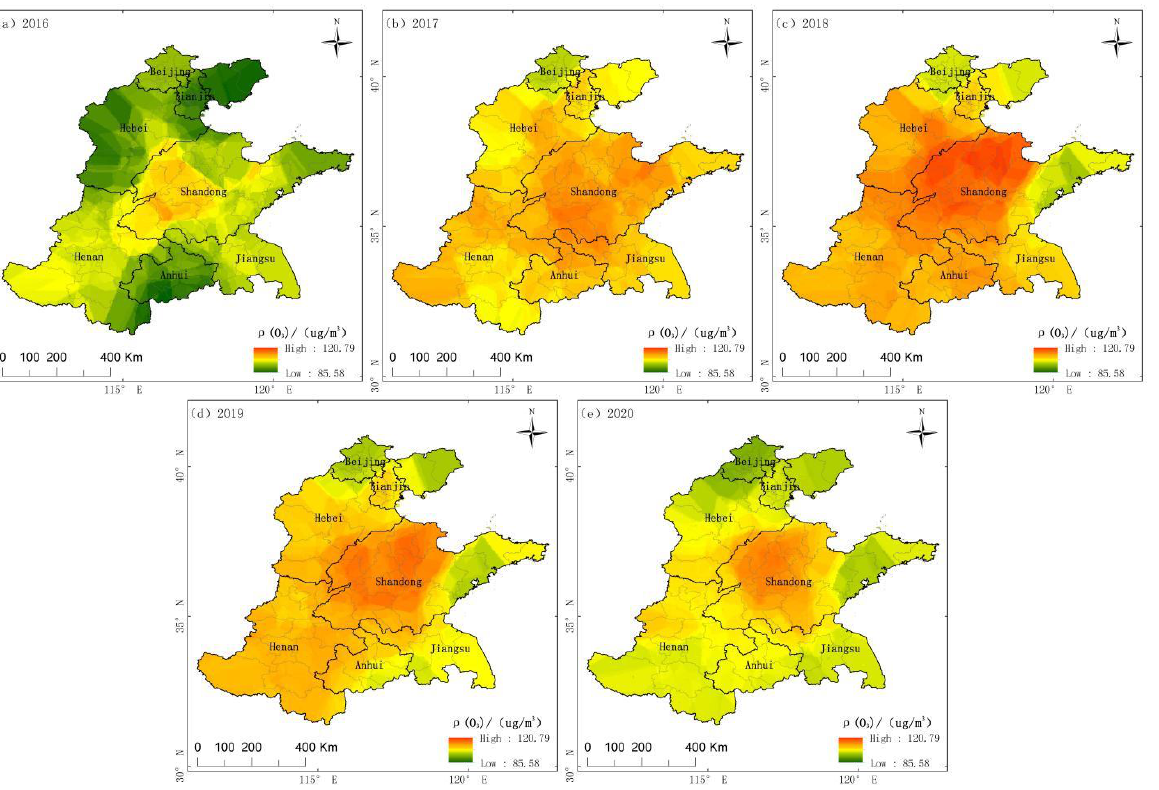
Figure 4. Annual spatial distribution map of O 3 in the NCP from 2016 to 2020: ( a ) Spatial distribution of O 3 in 2016, ( b ) Spatial distribution of O 3 in 2017, ( c ) Spatial distribution of O 3 in 2018, ( d ) Spatial distribution of O 3 in 2019, ( e ) Spatial distribution of O 3 in 2020.